Question: Provide a publication-style caption for this figure.
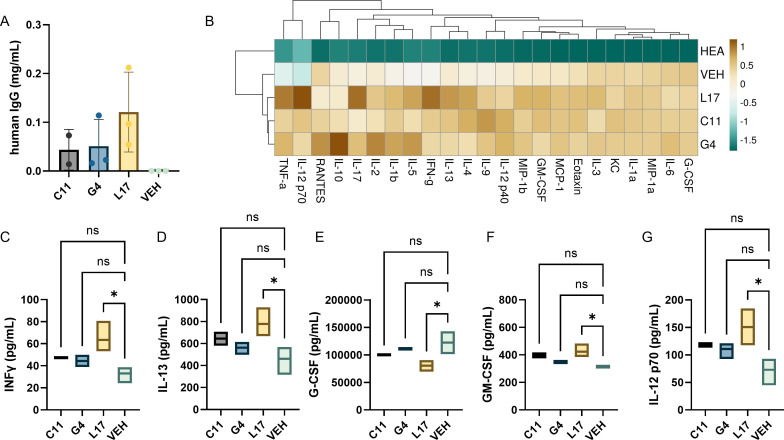
Answer: L17 alters serum cytokine responses following GAS infection. ( A ) Serum concentration of huMAbs compared to vehicle (VEH) measured 28 h post-infection. Data shown are mean ± SD ( n = 2, C11; n = 3 G4, L17, and VEH). ( B ) Heatmap of serum cytokine and chemokine concentrations across treatment groups. HEA denotes healthy, non-infected mice. Cytokine values were ln(x)-transformed and visualized by hierarchical clustering. ( C–G ) Box plots showing cytokines with statistically significant differences between treatment groups. Box size indicates max and min. Center lines indicate the mean. Statistical comparisons were performed by one-way ANOVA followed by Dunnett’s multiple-comparison test versus VEH control.